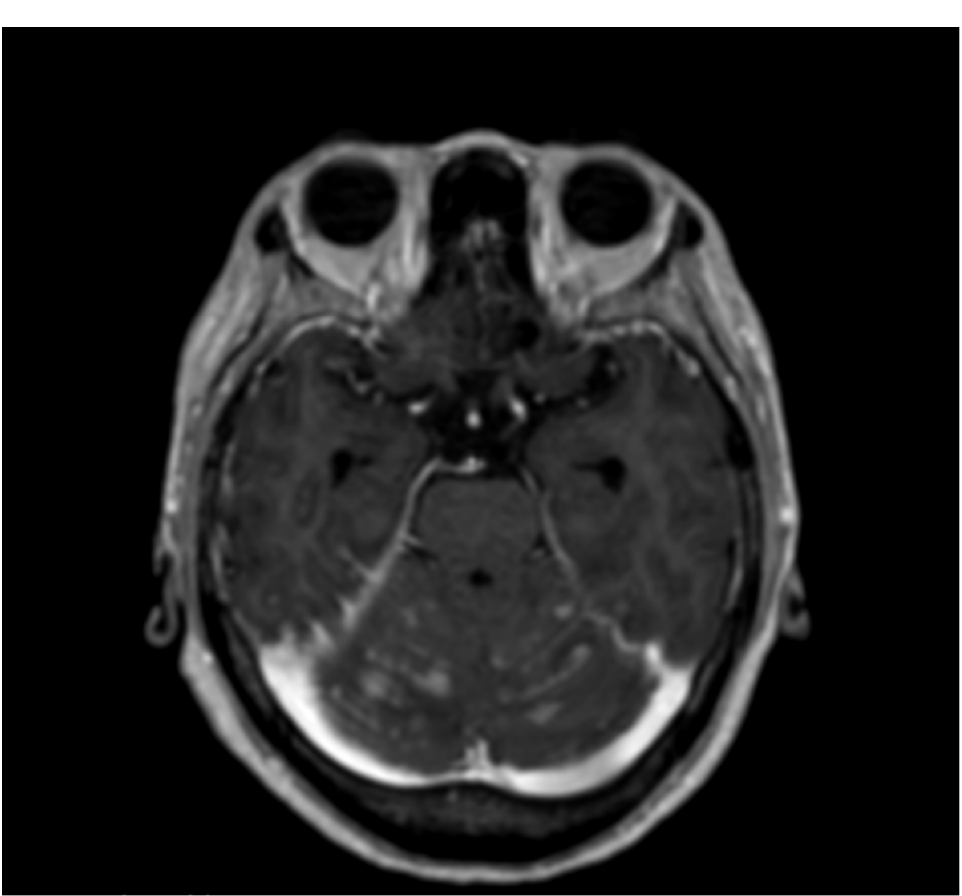
Figure 1. T1 weighted image with Gadolinium enhancement. Leptomeningeal enhancement along the sulci in the cerebellum.